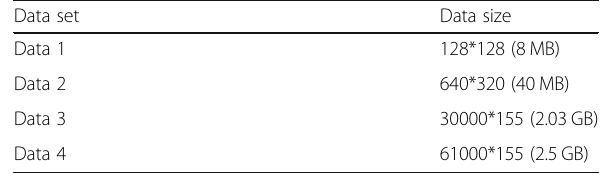
Table 1 Data sets used in the